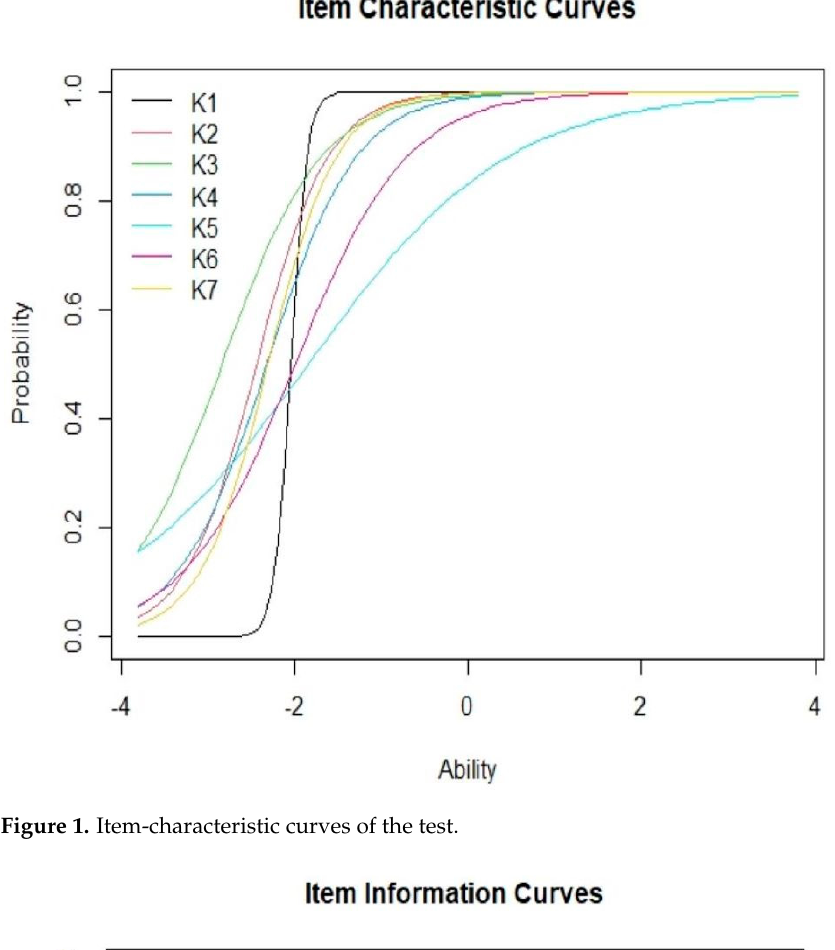
Figure 1. Item-characteristic curves of the test.